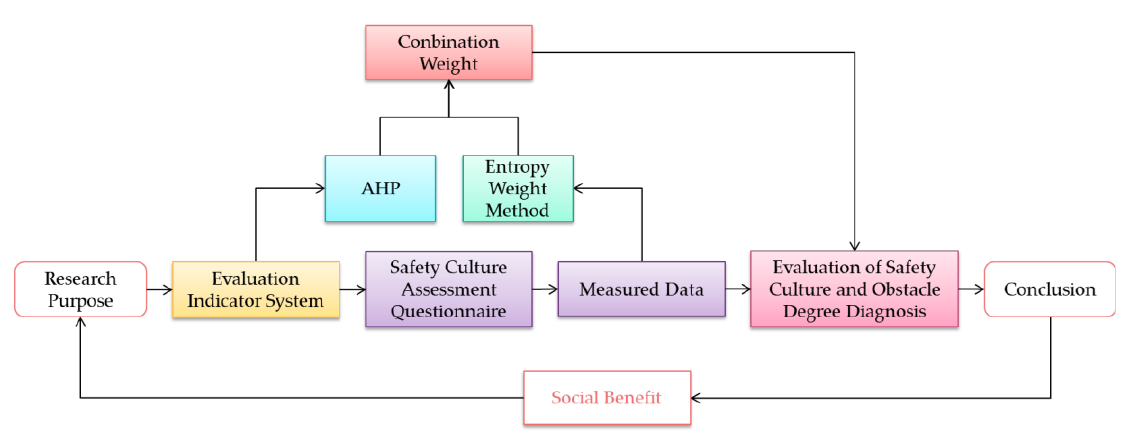
Figure 1. Flowchart of the Research.